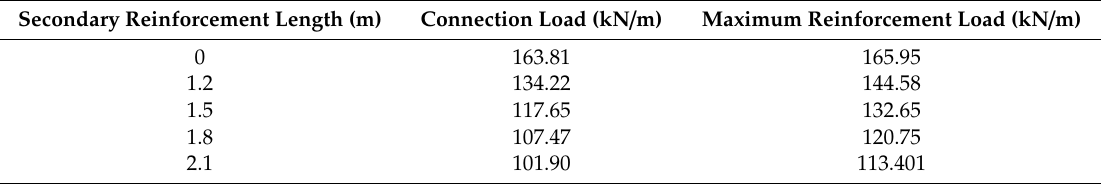
Figure 12. The distributions of ( a ) the connection load; ( b ) the maximum reinforcement load in the primary reinforcement. Table 5. Sum of connection loads and maximum reinforcement loads of walls in each primary reinforcement layer (effect of secondary reinforcement length).